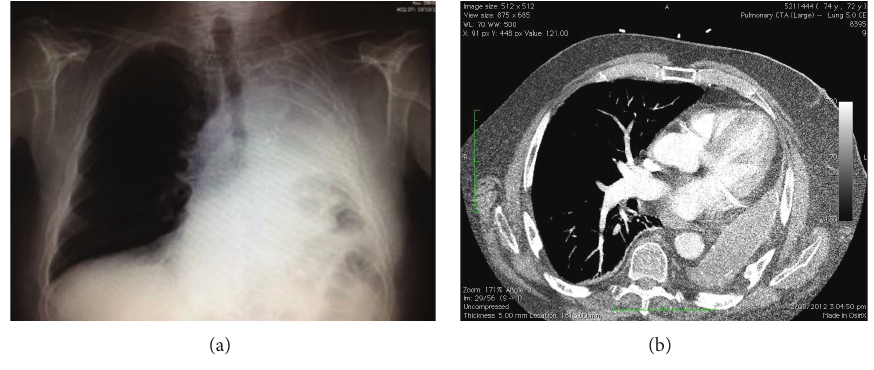
Figure 1: Preoperative chest X-ray and CT scan.